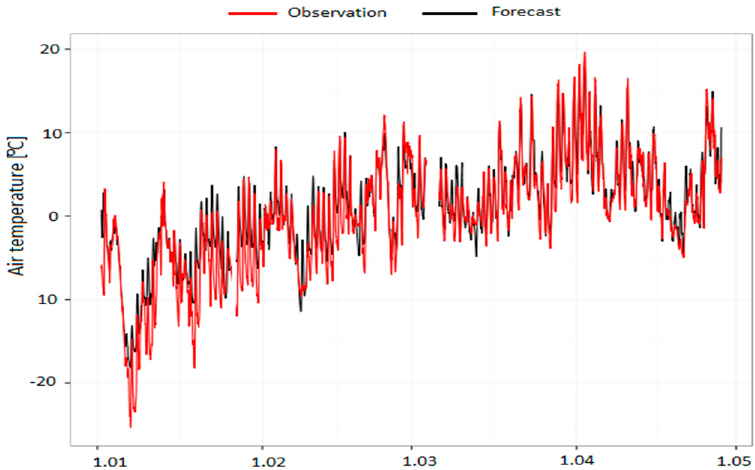
Figure 4. Measured and modeled values of air temperature (2 m above the ground) at Zakopane station for the period 1 January to 30 April 2017 for AROME CMC 2 km.